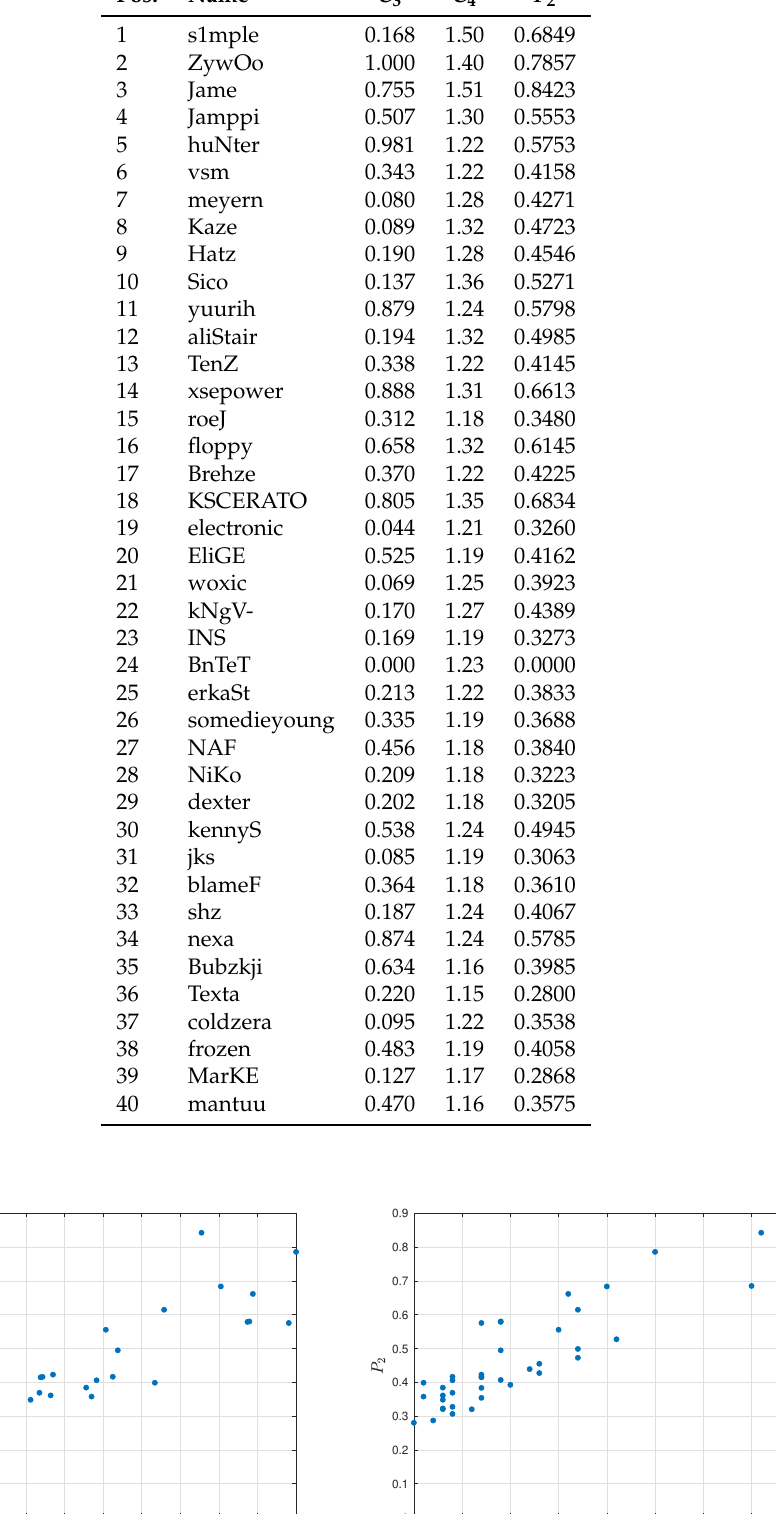
Table A1. The performance table of the selected criteria C 3 , C 4 and assessment model P 2 . Pos.